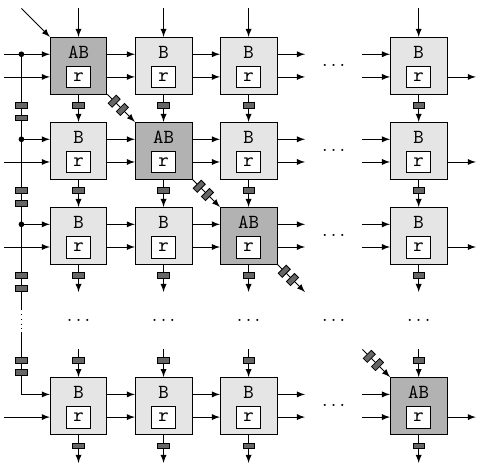
Figure 1: Layout of the processor array from